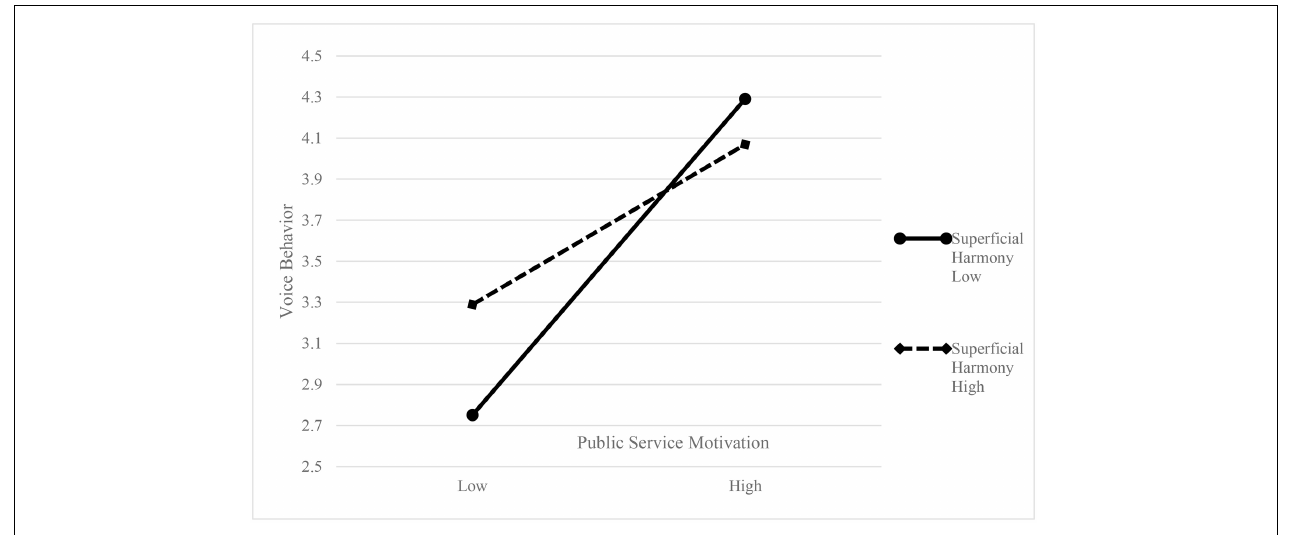
FIGURE 2 | The moderating effect of superficial harmony on the relationship between public service motivation and voice behavior.